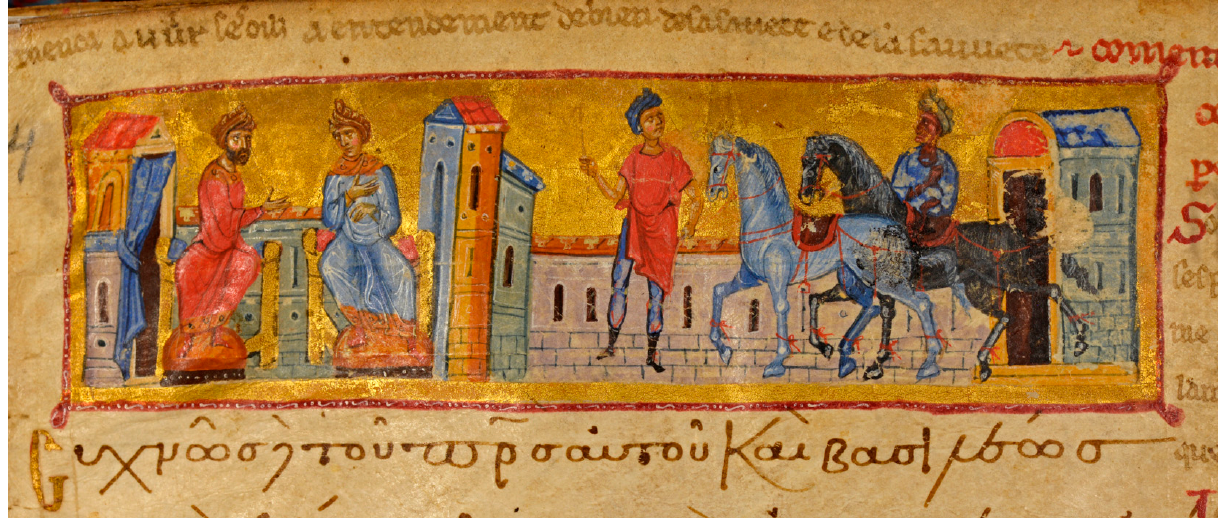
Figure 4. Paris. Bibliothèque nationale de France. Paris. gr. 1128, fol. 4v (detail). King Abenner con-